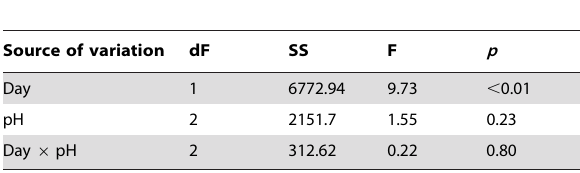
Table 4. Summary of ANOVA results of metabolism of larvae of Acropora digitifera